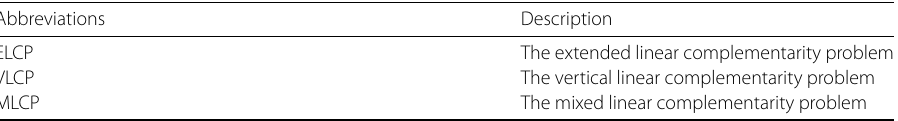
Table 1 Abbreviations in this